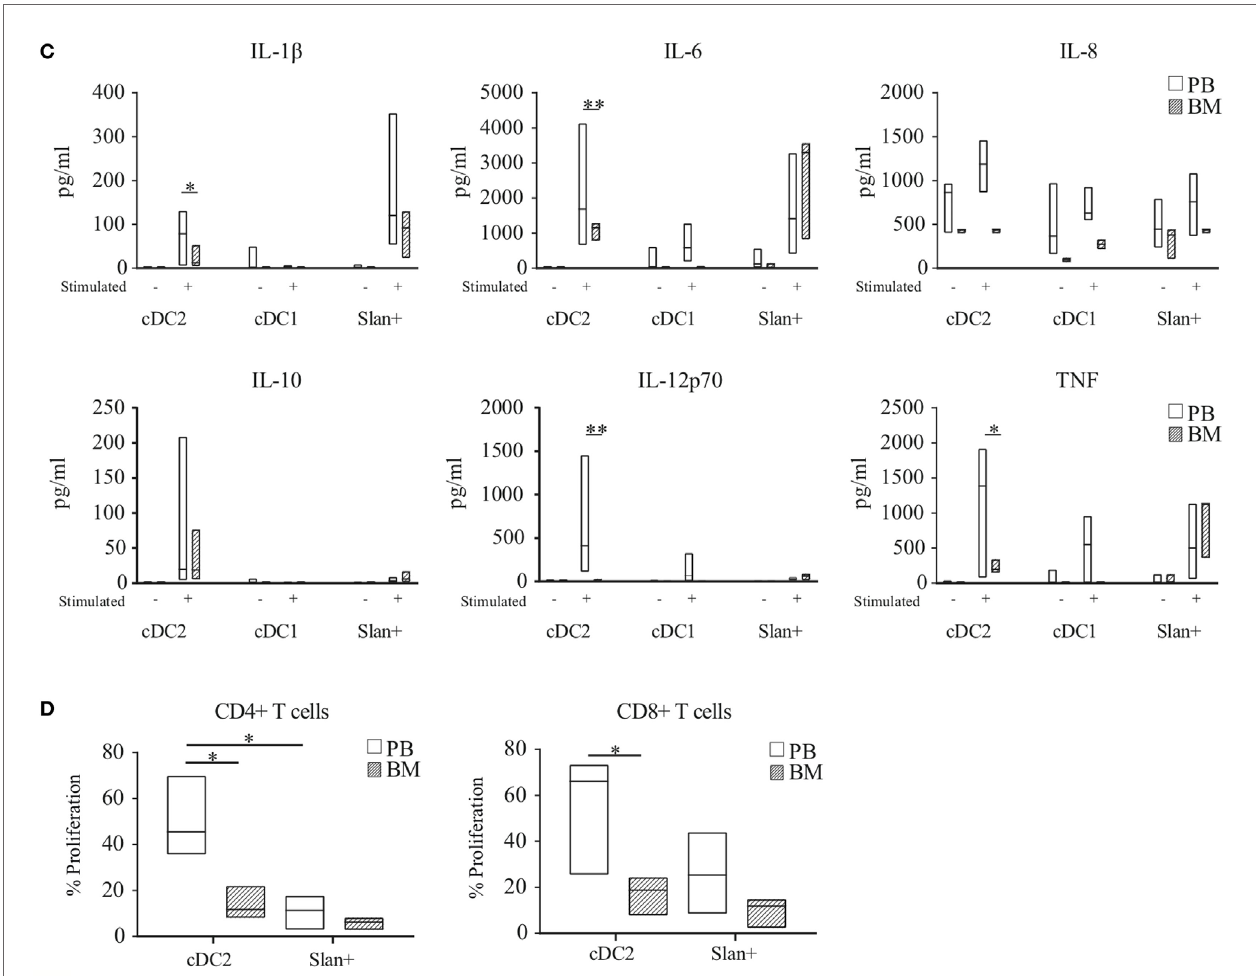
FigUre 6 | Functional validation of transcriptional findings in myeloid DC and slan + non-classical monocytes. (a) Ki-67 expression in peripheral blood (PB) and bone marrow (BM) subsets. A representative plot of one donor and percentages of positive cells of eight matched samples are shown. A Wilcoxon matched-pairs signed rank test was used to compare the compartments. (B) Maturation capacity upon TLR-stimulation. Isolated PB or BM cDC2 and slan + monocytes were either left unstimulated or were stimulated overnight with LPS + R848. Expression levels of CD80, CD86, and HLA-DR were assessed by flow cytometry. The fold change (FC) in median fluorescence intensity (MFI) values at baseline and after overnight culture (unstimulated or stimulated condition) was calculated. Median FC values for 6–10 PB and 3–4 BM (cDC2) or 8–12 PB and 3–4 BM (slan + ) experiments are shown. (c) Cytokine secretion assay. Culture supernatants of PB-derived cDC1 ( n = 3), cDC2, and slan + ( n = 6) cells and BM-derived cDC1 ( n = 2), cDC2, and slan + ( n = 4) cells, unstimulated and stimulated (cDC2 and slan + : LPS + R848, cDC1: Poly I:C + R848), were analyzed for the presence of different cytokines by cytometric bead array (CBA, pg, picogram). (D) Allogeneic mixed leukocyte reaction (MLR). CFSE-labeled peripheral blood lymphocytes (PBL) were co-cultured with PB or BM-derived cDC2 or slan + monocytes. The percentage of CFSE-diluted T cells was determined by using flow cytometry. Median values of four different experiments are shown. * p < 0.05, ** p < 0.01, and *** p <